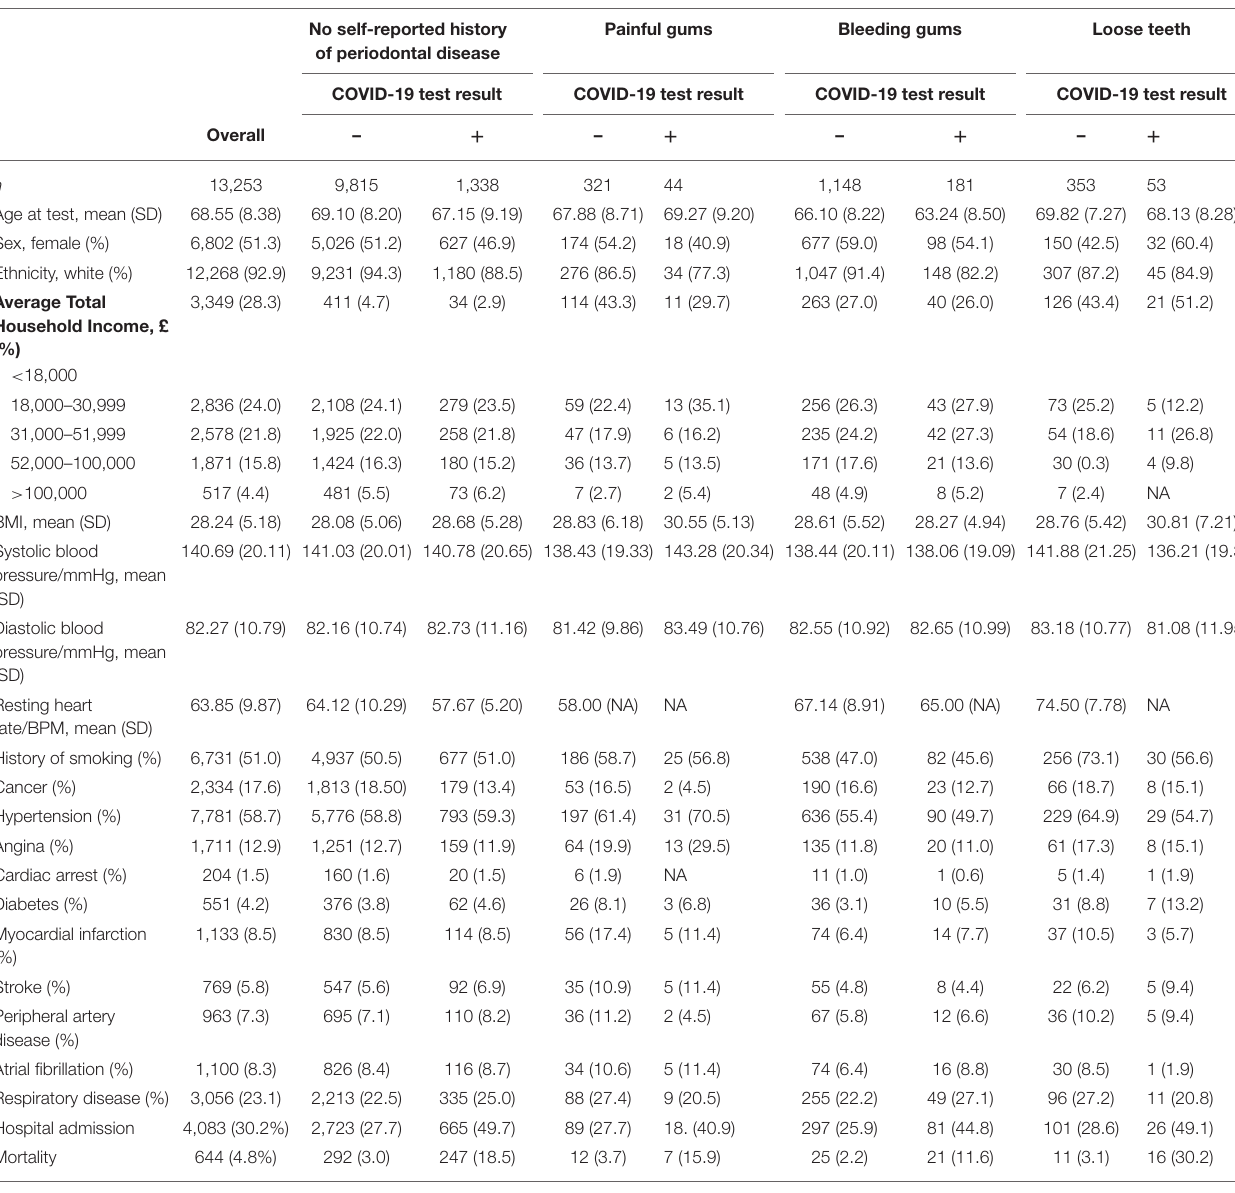
TABLE 1 | Summary table of UK Biobank participants stratified by oral health indicator and COVID-19 test